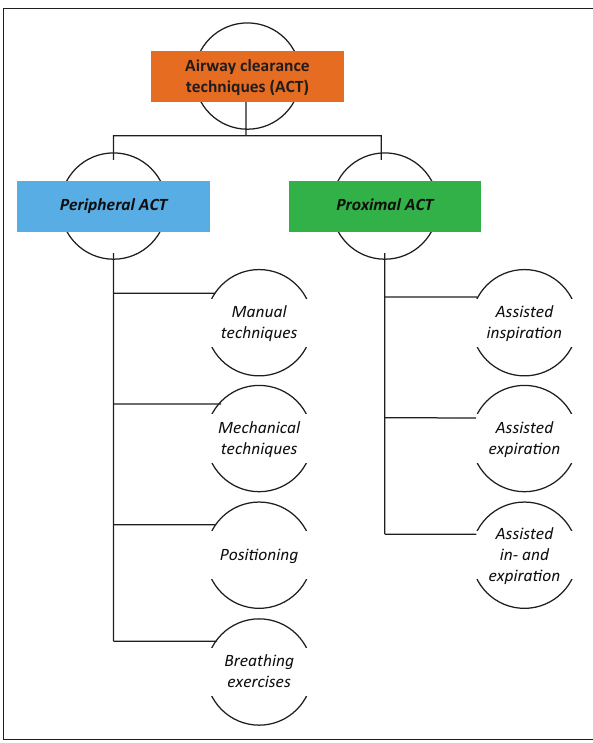
FIGURE 1: Peripheral and proximal airway clearance techniques, including cough